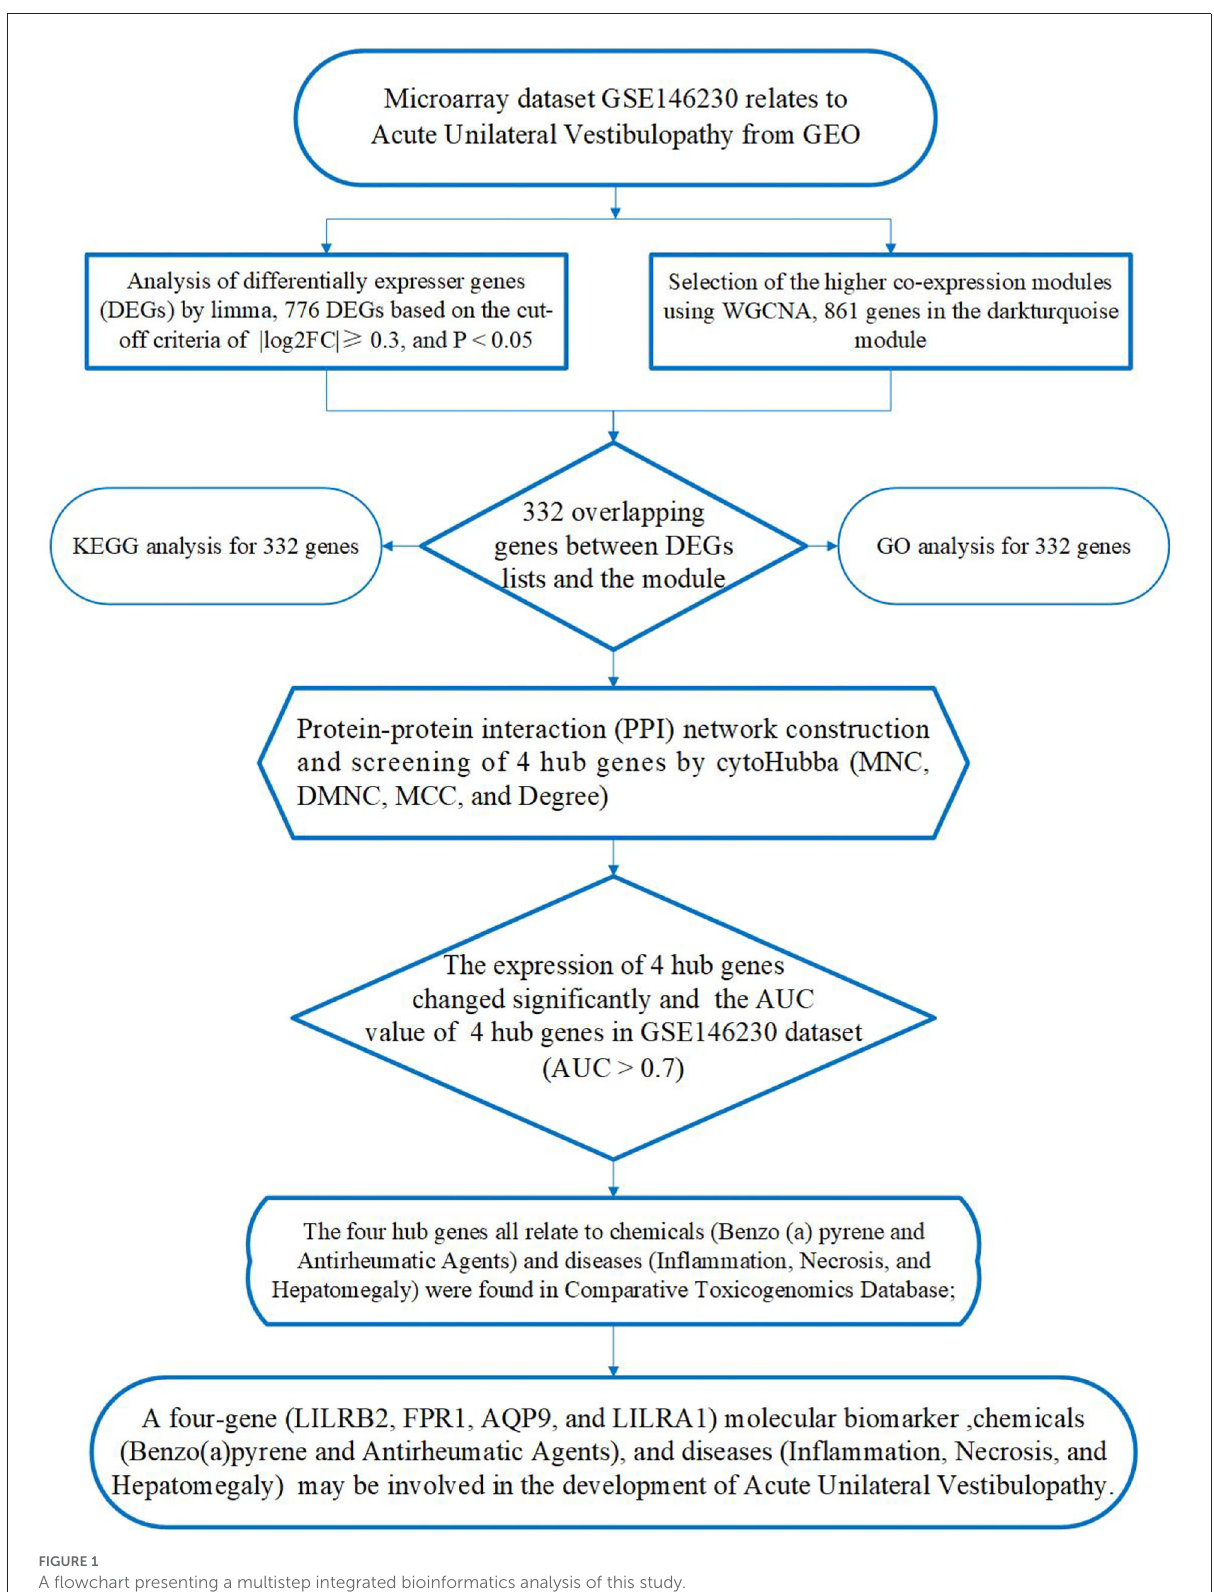
FIGURE1 A flowchart presenting a multistep integrated bioinformatics analysis of this